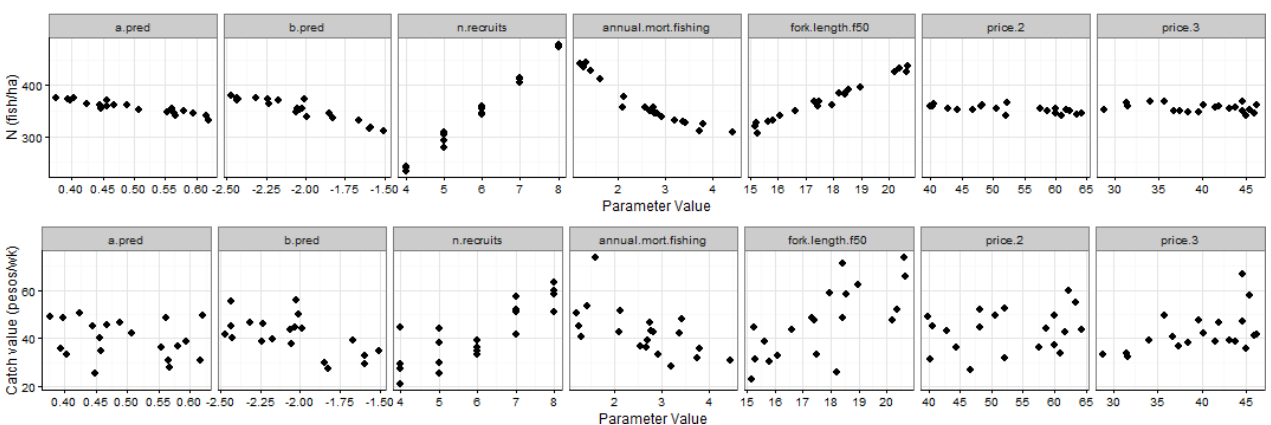
Fig. 4 . Sensitivity of population size (top panel) and catch value (bottom panel) to perturbations in fitted model parameters (y-axes of panels). a.pred and b.pred are unitless, n.recruits is the number of individuals entering the population per weekly time step, fishing mortality is expressed as an instantaneous value, fork length at 50% fishery selectivity is in centimeters, and the price variables are expressed in Dominican pesos